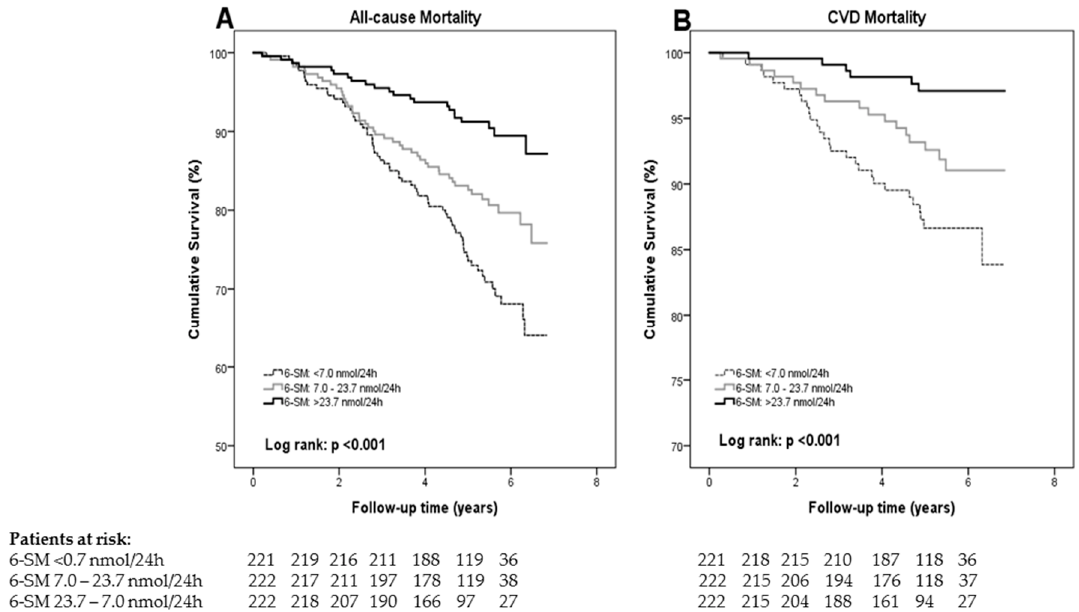
Figure 1. Kaplan–Meier curves for mortality of RTRs according to the tertiles of urinary 6-sulfatoxymelatonin excretion. ( A ) All-cause mortality, and ( B ) cardiovascular mortality. Below the horizontal axis, the numbers of patients still at risk of an event at the follow-up time-points 0, 1, 2, 3, 4, 5, and 6 years are shown. Abbreviations: 6-SM: 6-sulfatoxymelatonin, CVD: cardiovascular disease.